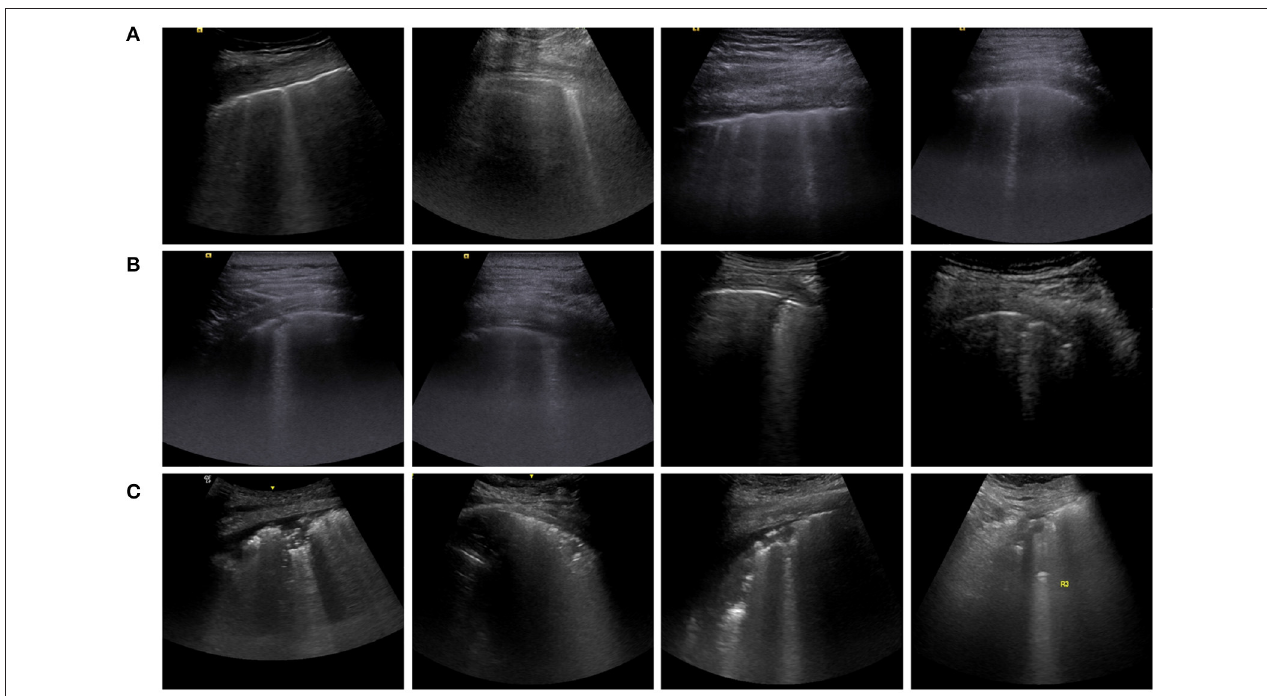
FIGURE 1 | Typical examples of abnormal ultrasound cases related to coronavirus disease 2019 (COVID-19). (A) The pleural line is jagged or concave. (B) The pleural line is broken. (C) The scanning area shows a wide range of dense white areas, with or without large